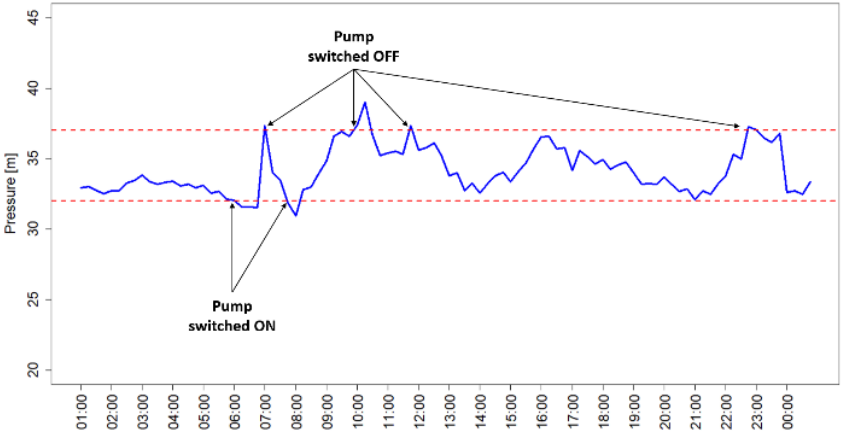
Figure 6. A schematic representation of an implicit pump control strategy based on min–max thresholds (red dotted lines) on the pressure value (in blue).